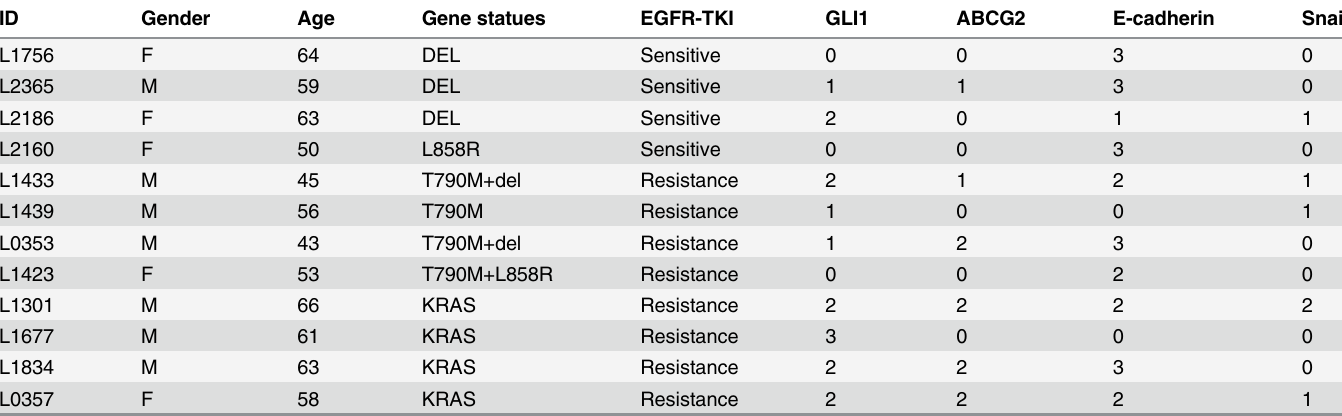
Table 1. Expression of GLI1, ABCG2, E-cadherin and Snail in NSCLC tissues tested by immunohistochemistry. ID Gender